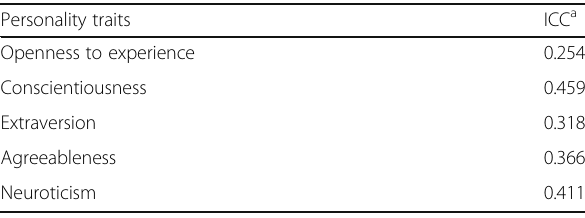
Table 1 Reliability between times of assessment Personality traits